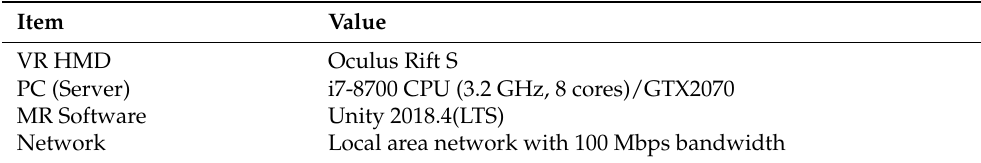
Table 1. Experimental system environment.